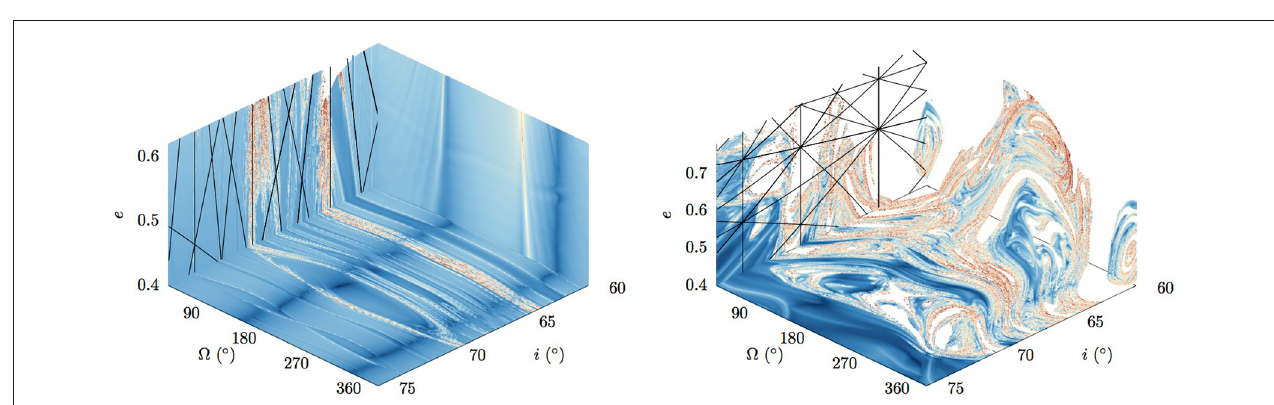
FIGURE 11 | These two FLI cubes, computed for a appear in black in the “action-action”